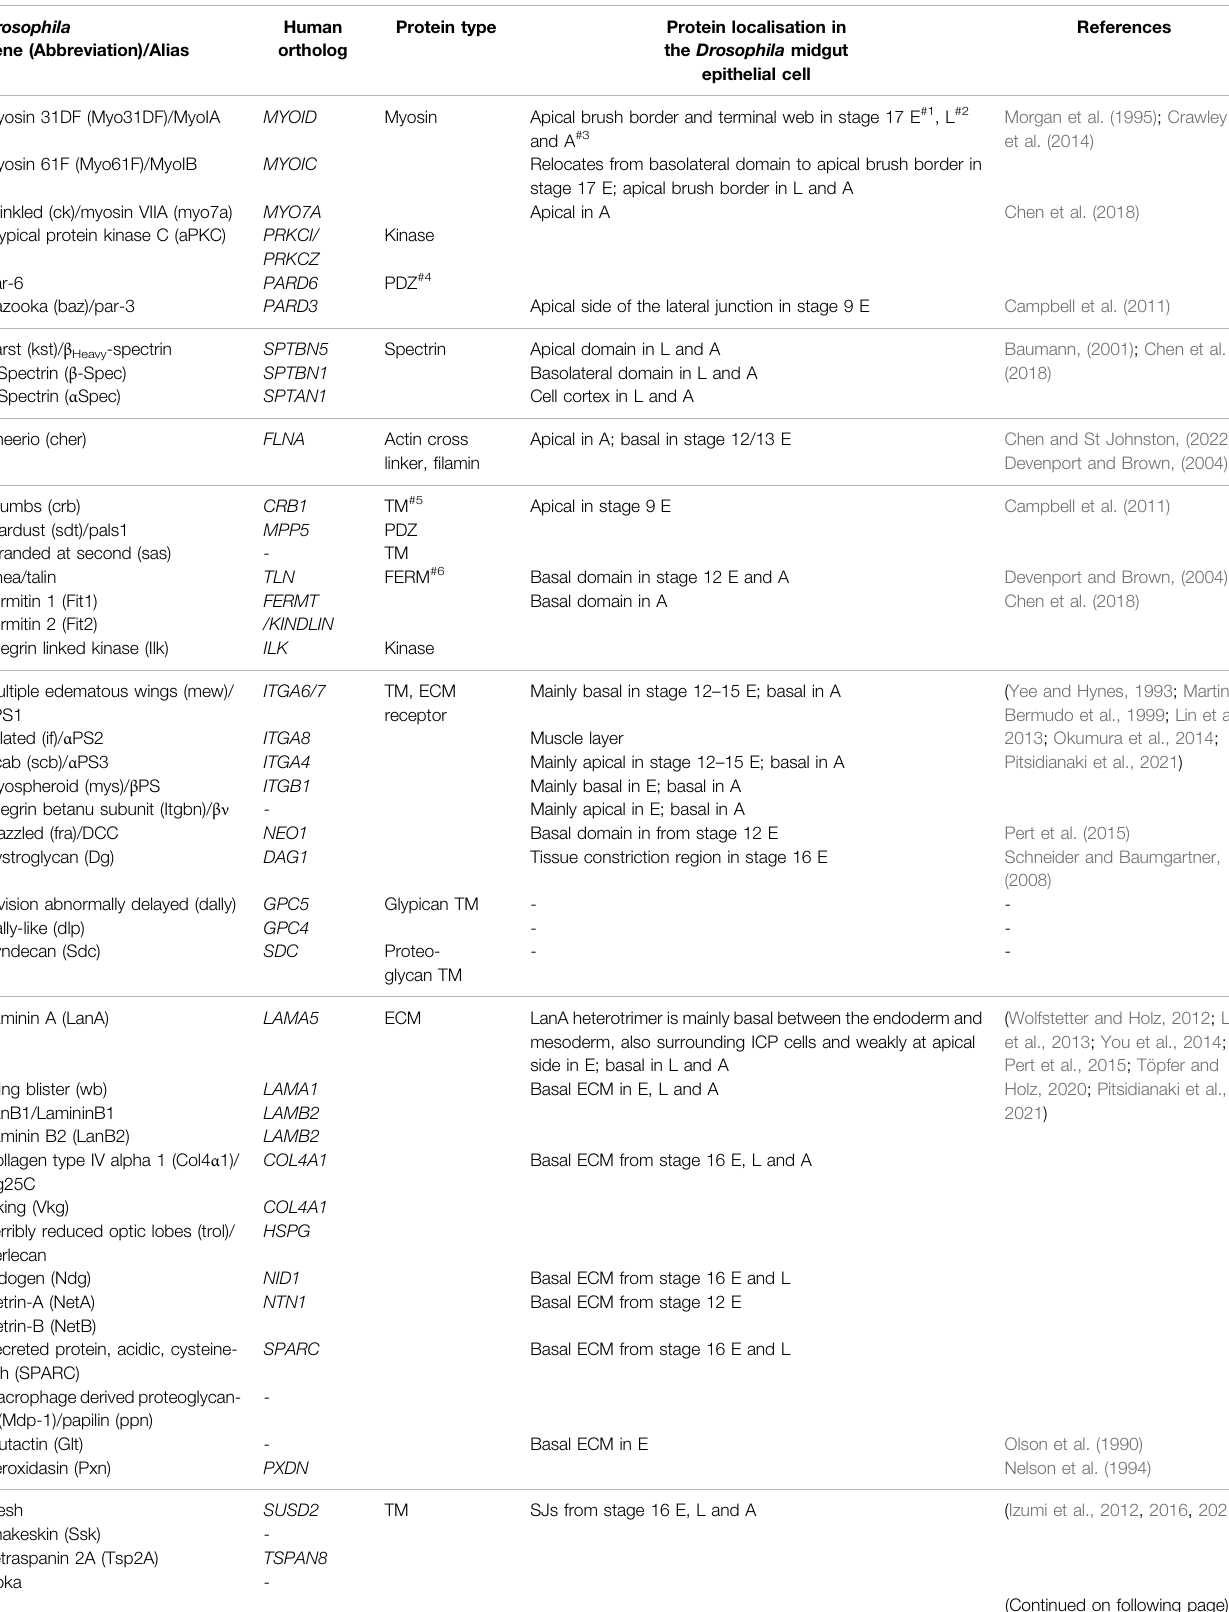
TABLE 1 | Drosophila genes and their encoded protein ’ s localization during midgut development.